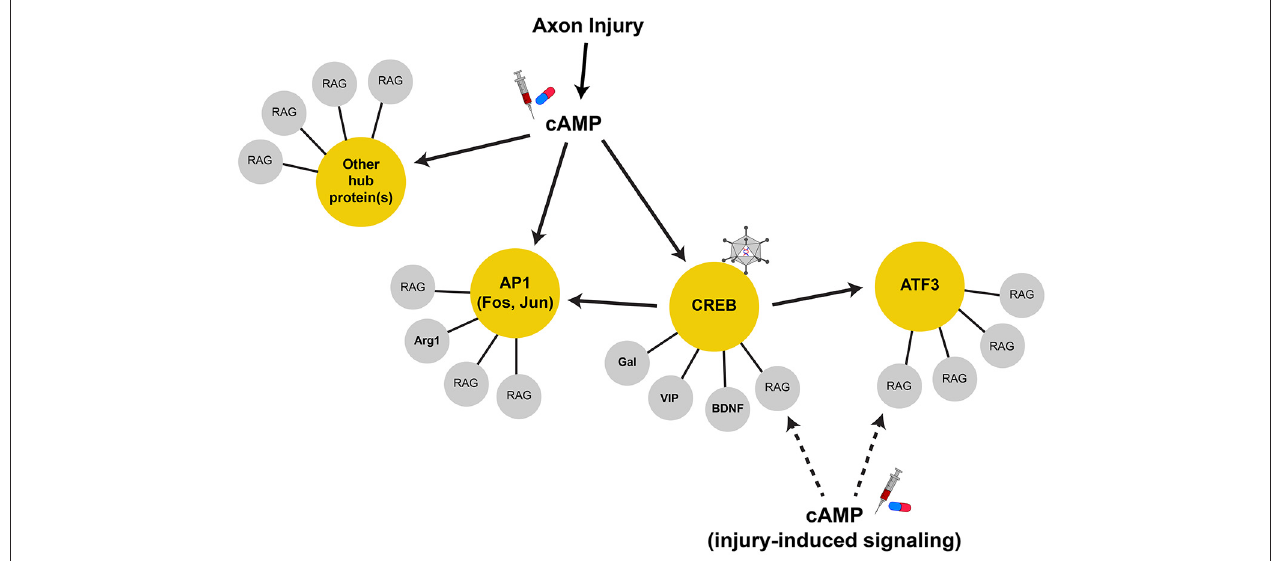
of the RAG transcription network and serves to coordinate the transcription of many terminal RAGs through their proximal hub proteins. These highly connected nodes are attractive therapeutic targets that can recapitulate more of the RAG response and can be targeted by viral-mediated gene delivery (i.e., constitutive-active CREB, virus cartoon). Additionally, injury-induced signals may also work locally and interact with the protein products of the transcribed RAGs to augment axon growth. Thus, strategies that increase/induce RAG expression along with activation of injury signals (i.e., cAMP, syringe and pill cartoon) may show synergy in promoting axon